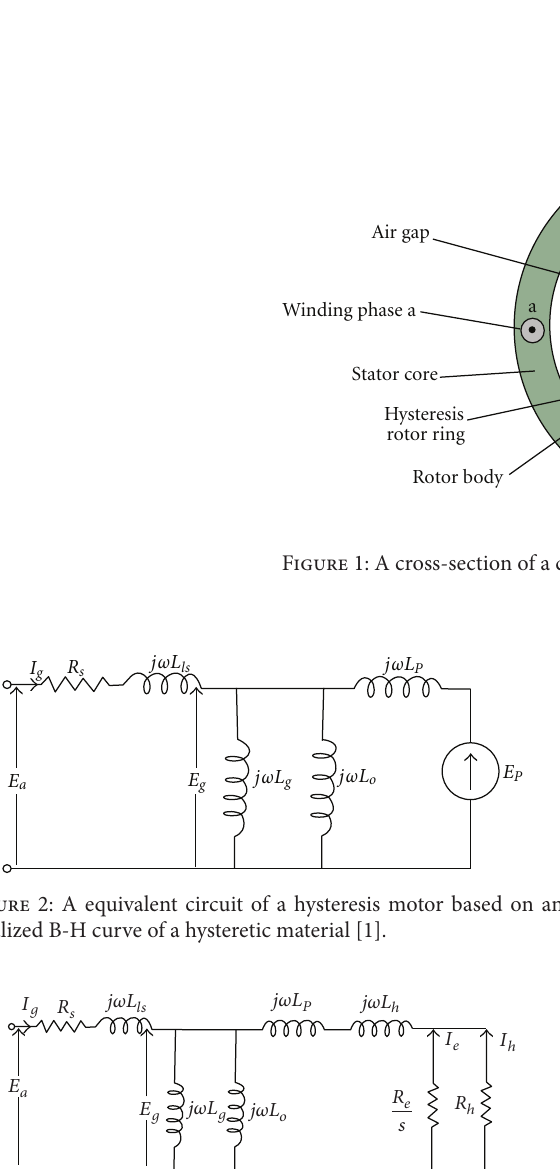
F 3: A steady-state equivalent circuit of a hysteresis motor. e values of air gap inductance